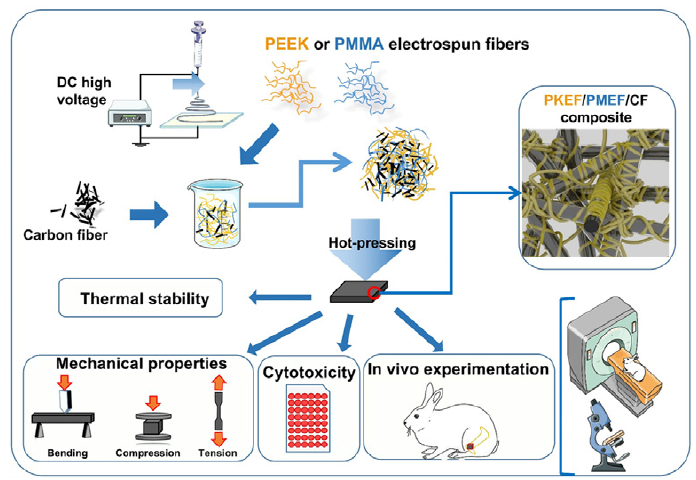
Figure 3. Preparation process and related tests of ternary composites [72].